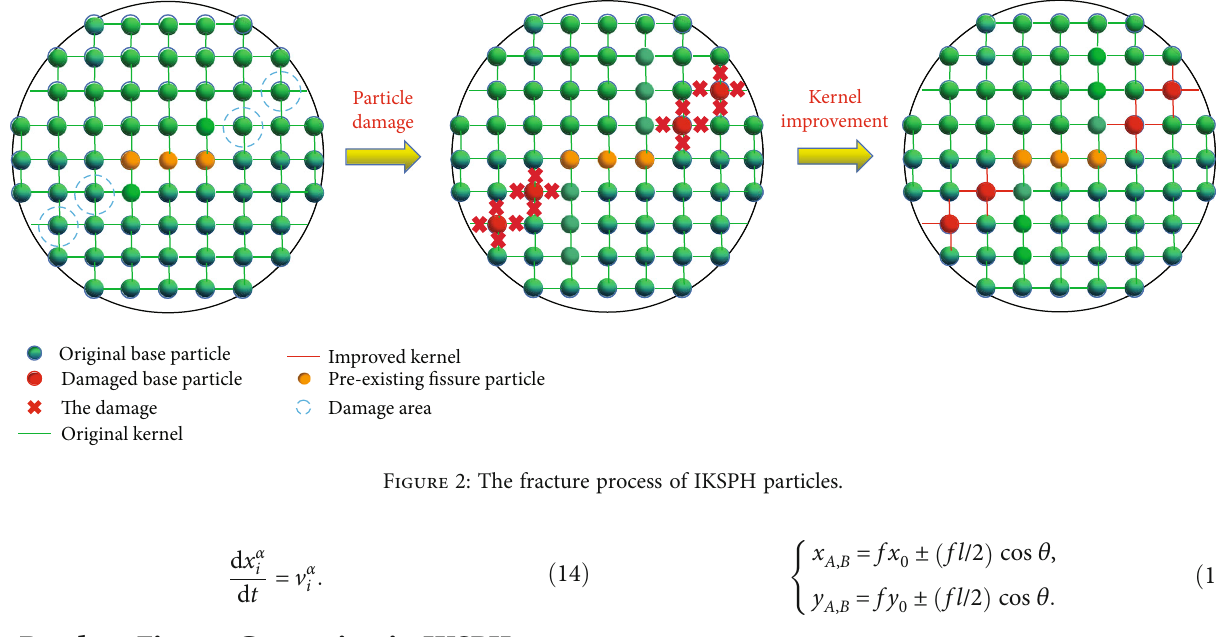
Figure 2: The fracture process of IKSPH